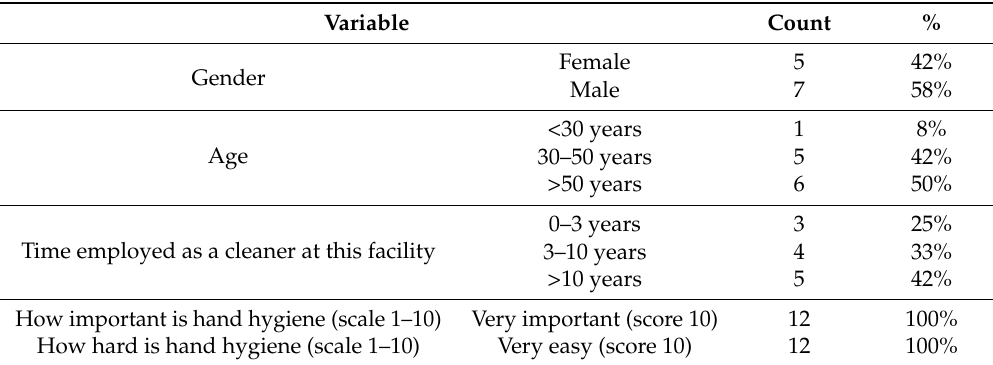
Table 1. Demographics of focus group